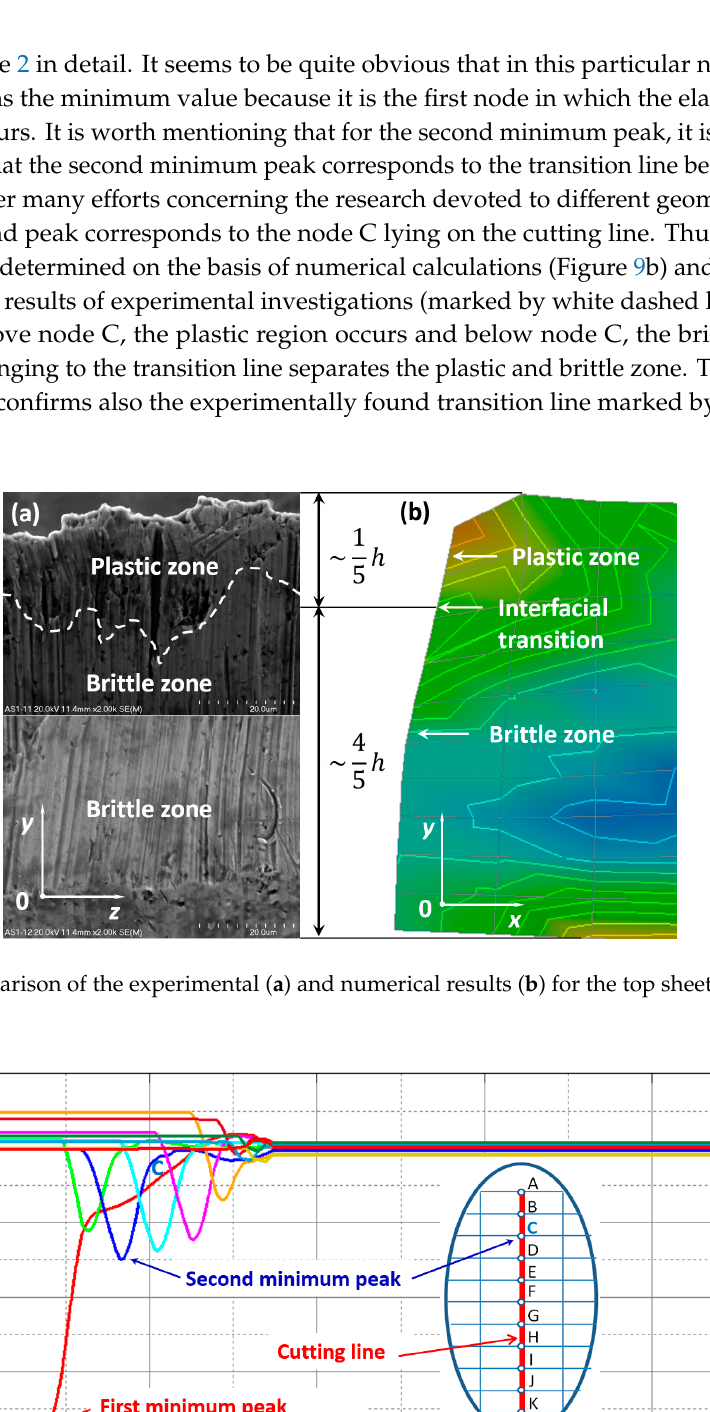
Figure 11. Comparison of the experimental ( a ) and numerical results ( b ) for the bottom sheet in a bundle. The main distinction between both sheets consists in the size and number of defects in the shape of micro-voids observed in the plastic zone; they are slightly larger and more numerous in the bottom sheet. In the lower part of the bottom sheet, a larger number of brittle walls arose than in the first sheet.